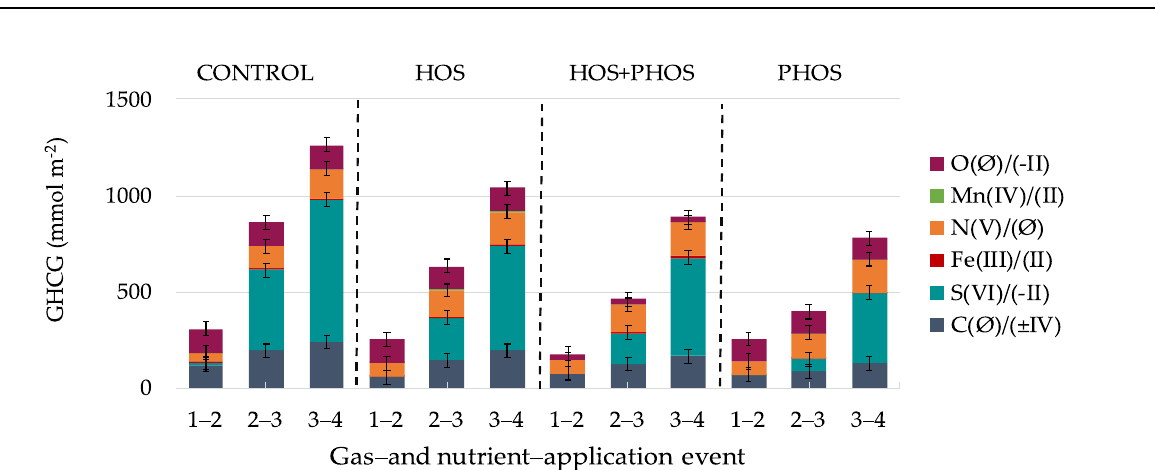
Figure 6. Process-dependent emissions of GHCG in experimental reactors. [Sed] = 14.1 g (dw) L − 1 ; [TOC] = 11,302 mmol m-2; I = 2.6 mmol L − 1 ; T = 28.2 ± 1.5 °C; for Eh and pH values, see Table